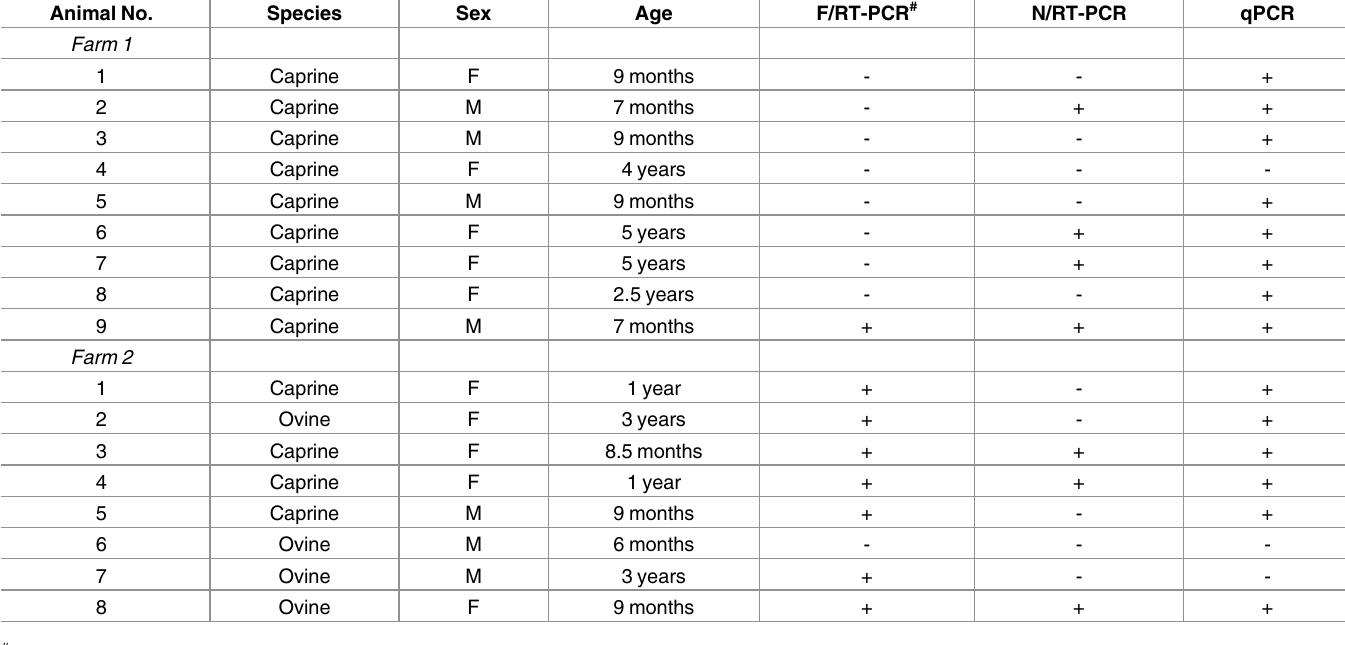
Table 2. Details of samples collected and PCR test results. Animal